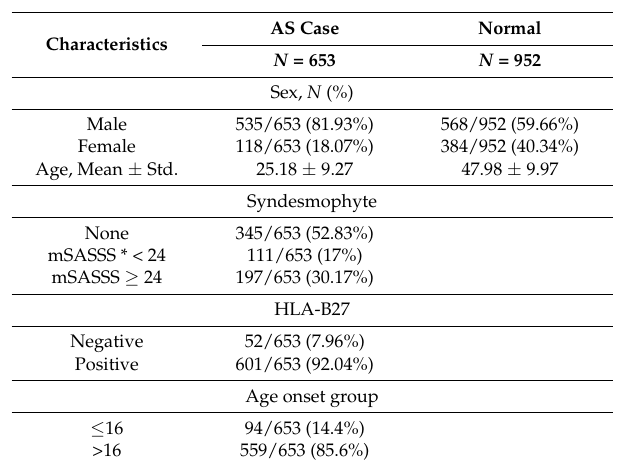
Table 1. Clinical characteristics of Taiwanese ankylosing spondylitis (AS) and normal controls.